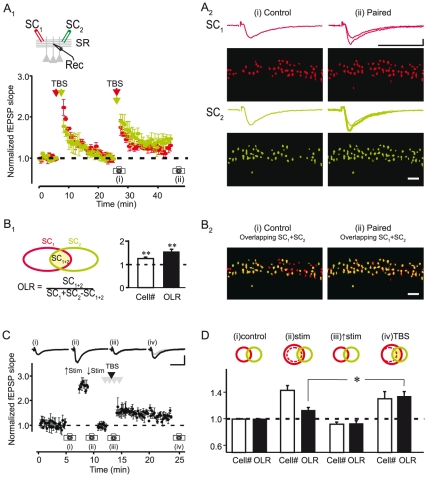
Associative LTP of two independent Schaffer collateral pathways merges the ensembles of pyramidal cells recruited by the two pathways.A1, Summary plot of fEPSPs showing associative LTP induced by simultaneous (paired) theta burst stimulation (TBS) of two SC pathways, while prior independent (unpaired) TBS does not cause potentiation (n = 4). Inset, recording configuration. A2, fEPSPs and cell ensembles evoked by each pathway (red, green) in one experiment at the times indicated on the summary plot. Scale bar, 0.2 mV and 20 ms. B, Associative LTP significantly increases the overlap ratio (OLR) of the two SC ensembles. B1, OLR was measured as the cells common between the two ensembles (SC1+2) divided by the total cells in the two ensembles (SC1 + SC2 - SC1+2, we subtract SC1+2 in order not to count cells common to both ensembles twice). Summary data plot the increase in total cells (SC1 +SC2) and OLR of the two ensembles normalized to control conditions (n = 4 slices; **, p<0.01). B2, Overlay of the two SC-evoked neuronal ensembles (red, green) shown in (A2). Yellow cells indicate neurons common to the two ensembles. (C,D) Increasing afferent input by increasing stimulus strength expands the size of cell ensembles but associative LTP causes a greater increase in overlap between two SC ensembles. C, Associative LTP was induced by pairing a weak stimulus (one TBS, black arrow) in one pathway (black traces) with a strong stimulus (four TBS, gray arrow) to the other pathway (not shown). Cell ensembles were measured under control conditions (i), following an increase in stimulus strength (ii), when stimulus strength was returned back to control (iii) and following associative LTP (iv). D, Summary data showing change in total number of cells and OLR relative to control conditions for changes in stimulus strength and associative LTP (n = 3; *, p<0.05).